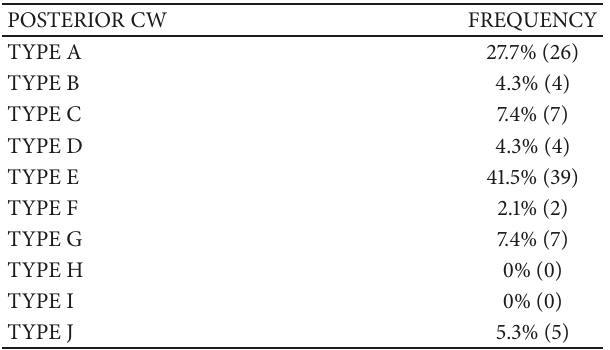
Table 3: Proportion of posterior circulation variants.